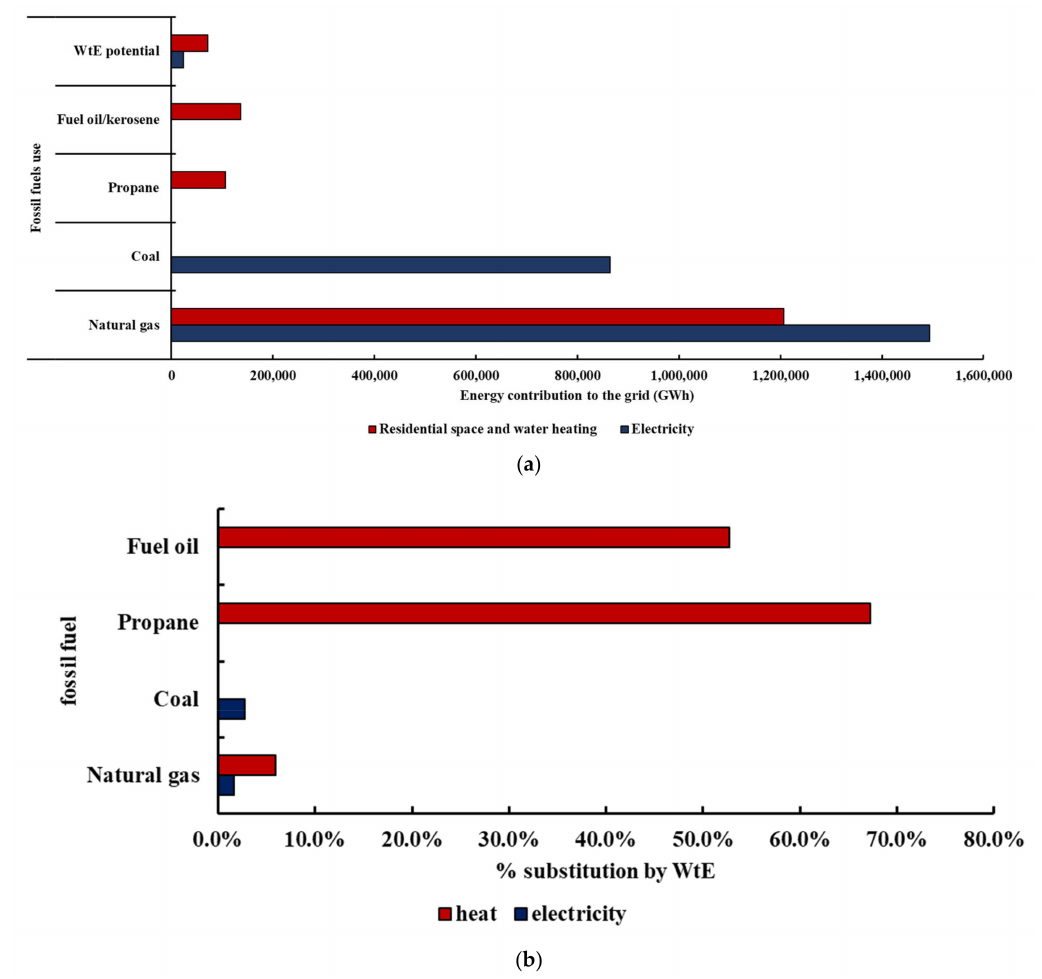
Figure 5. Fossil fuels used and WTE potential to substitute fossil fuels in the U.S.: ( a ) total amounts, and ( b )% substitution by WTE (WTE/fossil